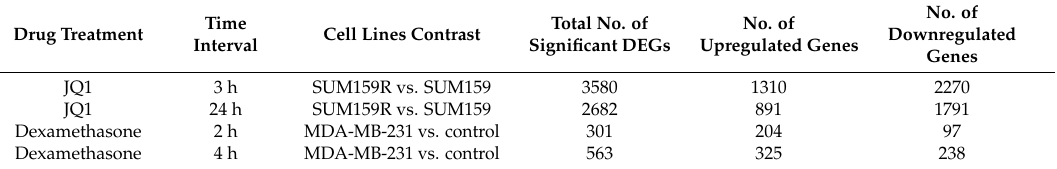
Table 1. Total number of differentially expressed genes (DEGs) at each time interval of drug treatment.